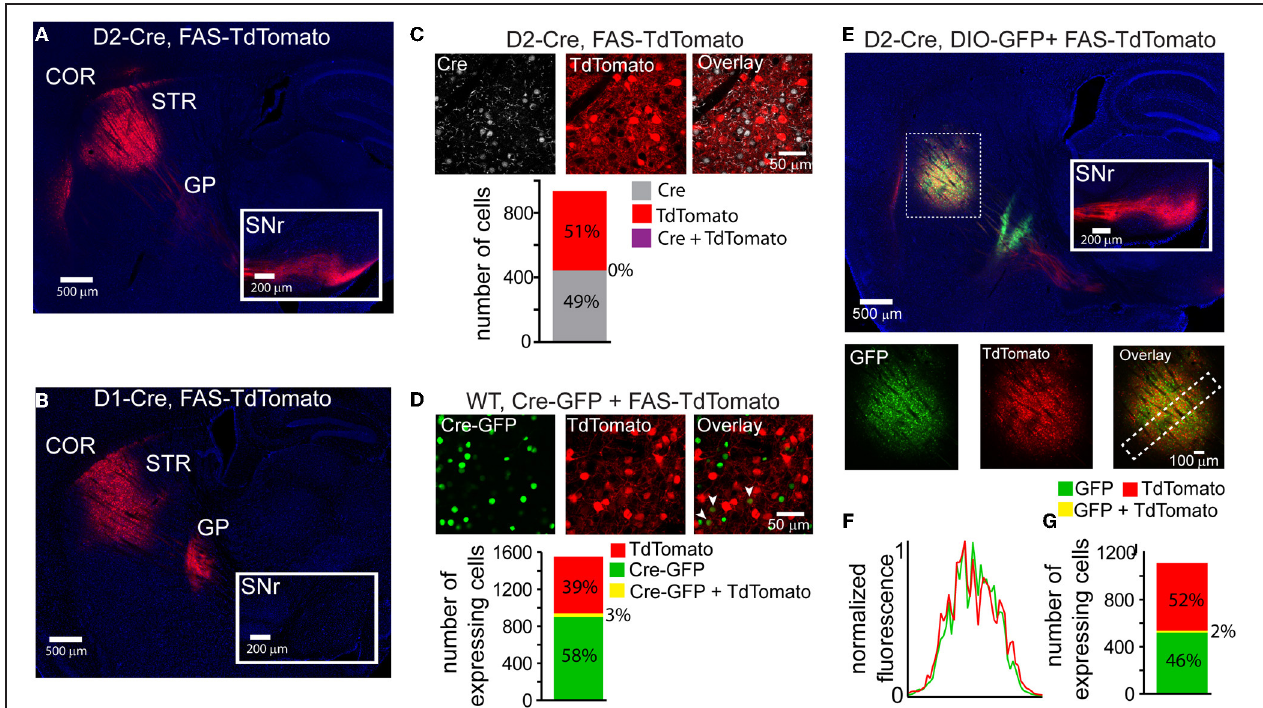
FIGURE 4 | LoxFAS excision achieves efficient Cre-Off rAAV expression that does not interfere with DIO Cre-On expression. (A) Sagittal section through a D2-Cre mouse infected with FAS-TdTomato in the striatum. TdTomato is excluded from iMSNs. TdTomato + axons arborize in the SNr (inset) but only minimally in the GP, consistent with expression in dMSNs. (B) Sagittal section through a D1-Cre mouse infected with FAS-TdTomato in the striatum. TdTomato expression is excluded from dMSNs. TdTomato + axons leaving the striatum target the GP, but not the SNr (inset), consistent with exclusion from dMSNs. (C) Antibody staining against Cre in D2-Cre striatum infected with FAS-TdTomato reveals efficient Cre-Off expression in the presence of Cre. Top , a single confocal plane showing Cre + nuclei excluded from interspersed TdTomato + cells. Bottom , confocal imaging through infected and stained tissue volumes ( N = 4 infections, N = 929 cells) revealed that TdTomato expression ( N = 477 cells) was completely absent in Cre + cells ( N = 452). (D) Co-infection of rAAVs Cre-GFP and FAS-TdTomato into the striatum of a wild type (WT) mouse leads to efficient exclusion of TdTomato in Cre-GFP expressing cells. Top, a single confocal